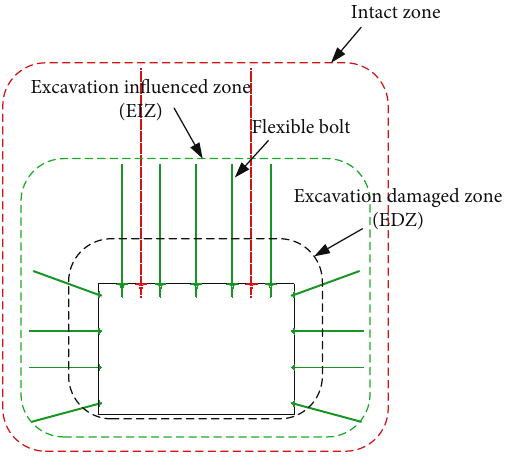
Figure 6: TADL supporting